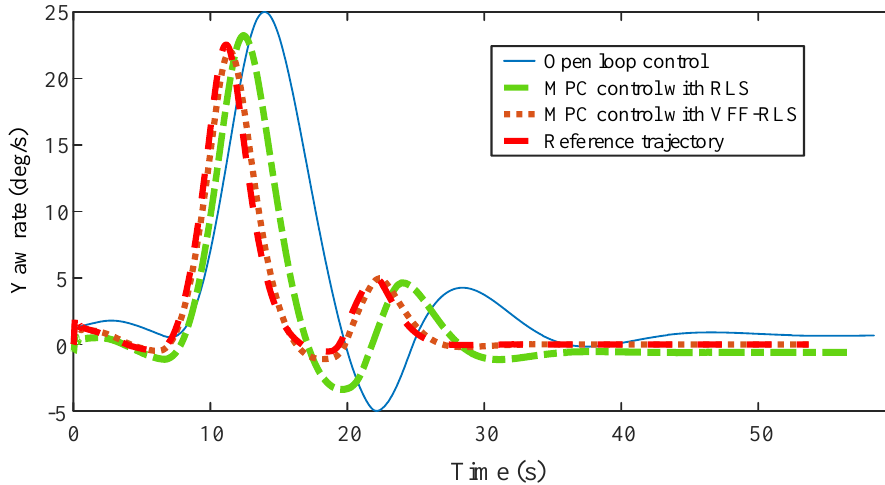
Figure 17. Yaw rate under Scenario B.